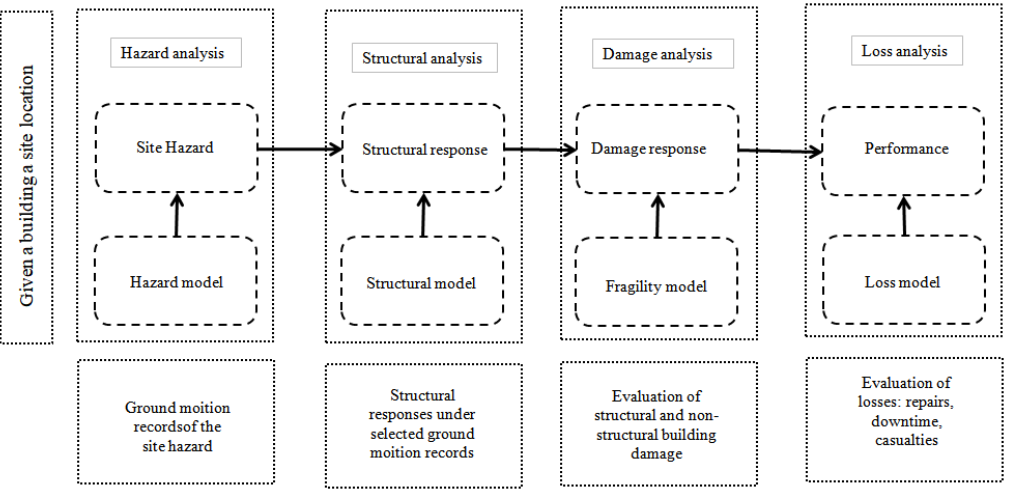
Figure 6. It specifies the likelihood of exceeding the judgment element, such as the amount of financial gains, downtime, or casualties (Reproduced from [37], the name of the publisher: